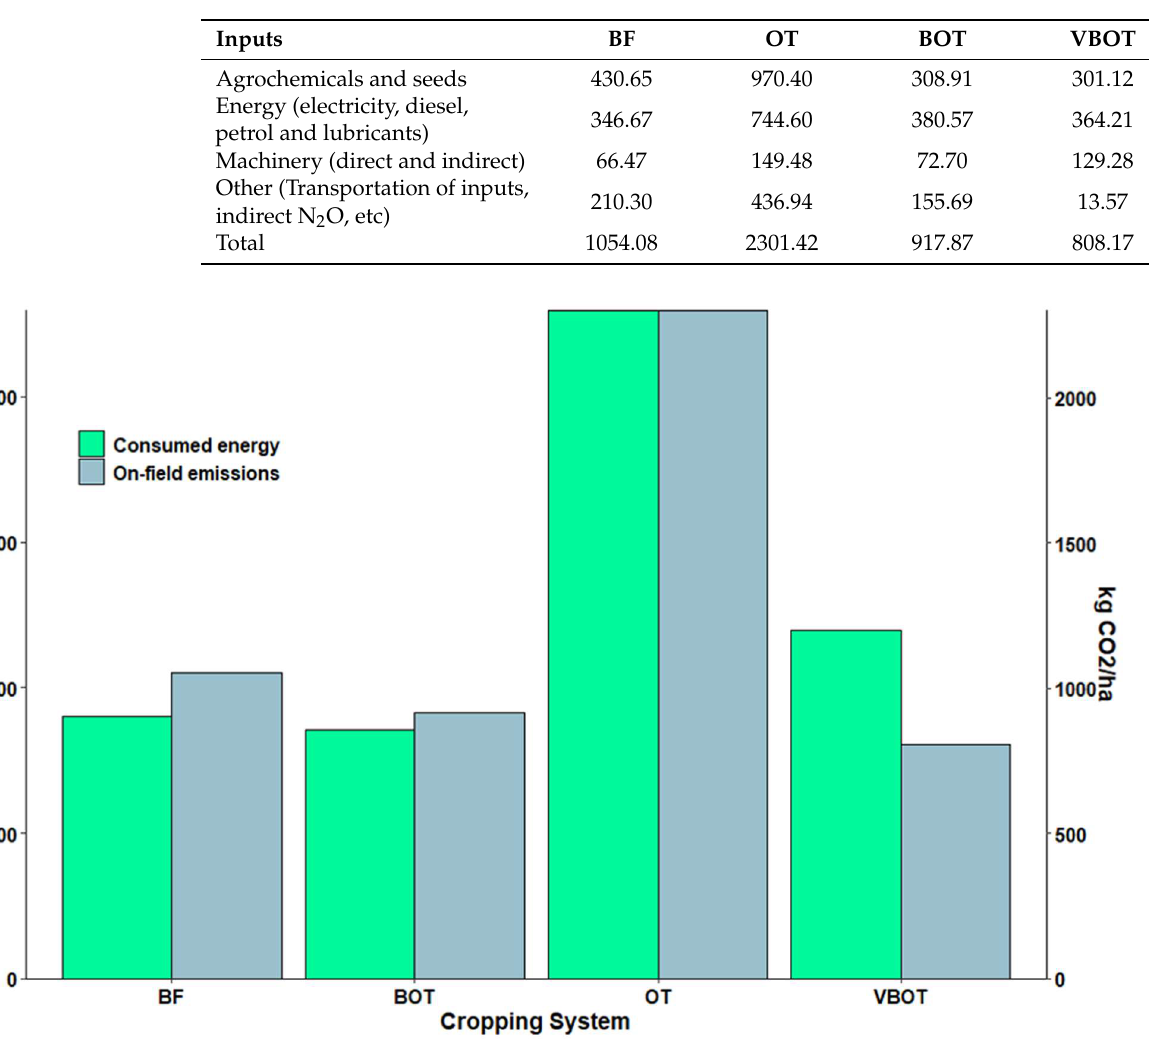
Table 3. Economic data for the four cropping systems.